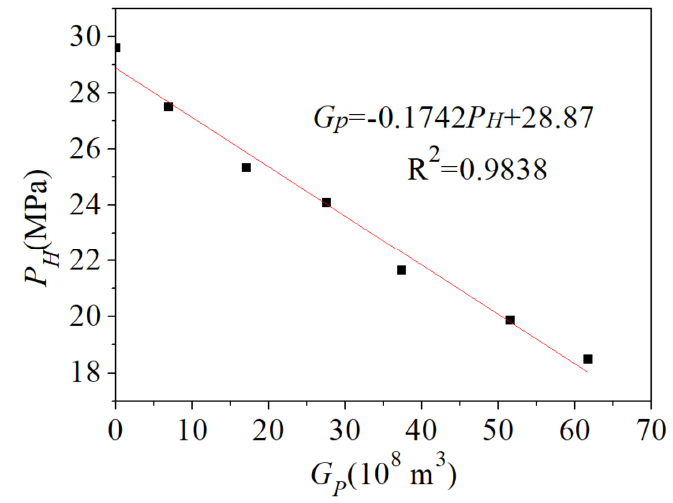
Figure 12. Validation results by the material balance equation of gas reservoir Z1.